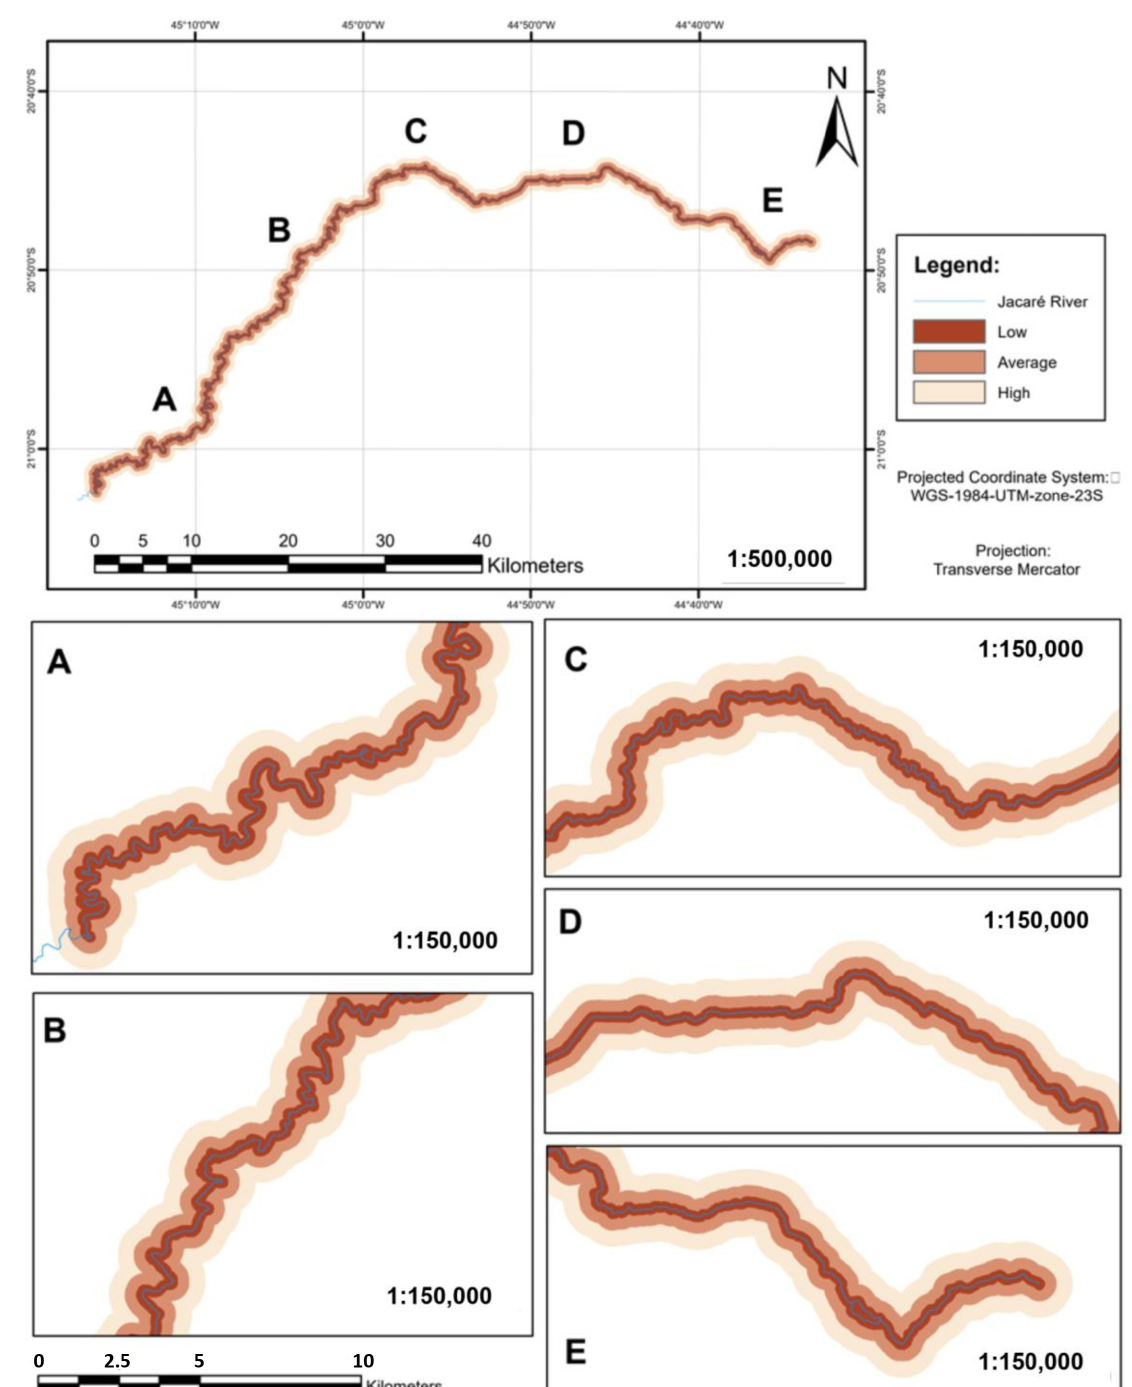
Figure 10. Map of the distance from the forest fragment to the reforestation sites. ( A – E ) are the regions with the most significant potential for reforestation.